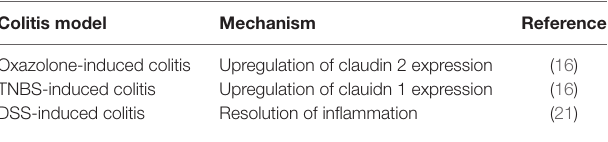
tABLe 1 | Mechanisms employed by Th9 cells in regulating ulcerative colitis in various mice